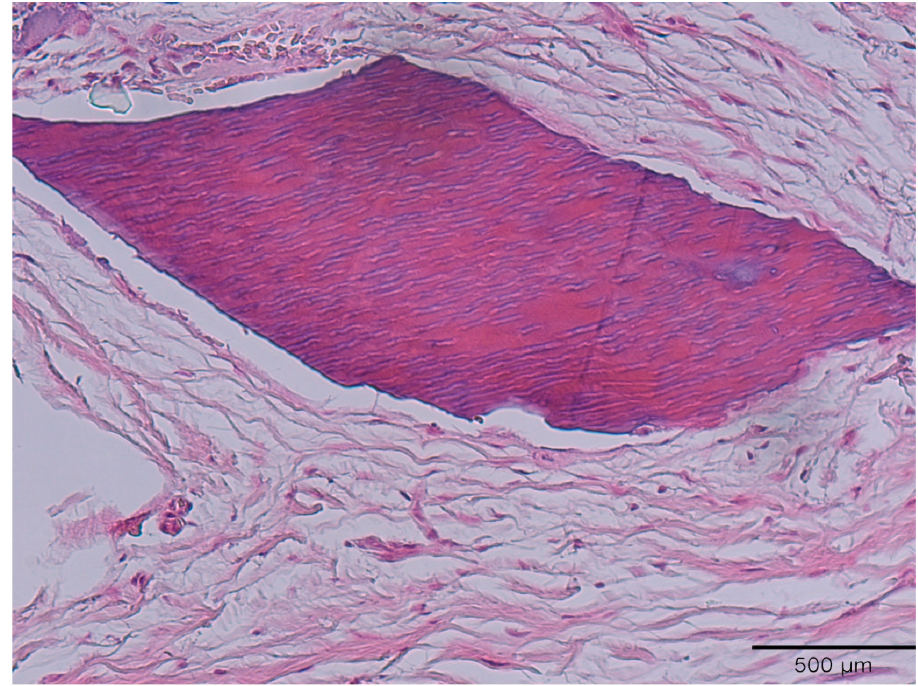
Figure 4. Evaluation at three months with high magnification, in which one can see dentinal tubes inside the particles and encompassing connective tissue.